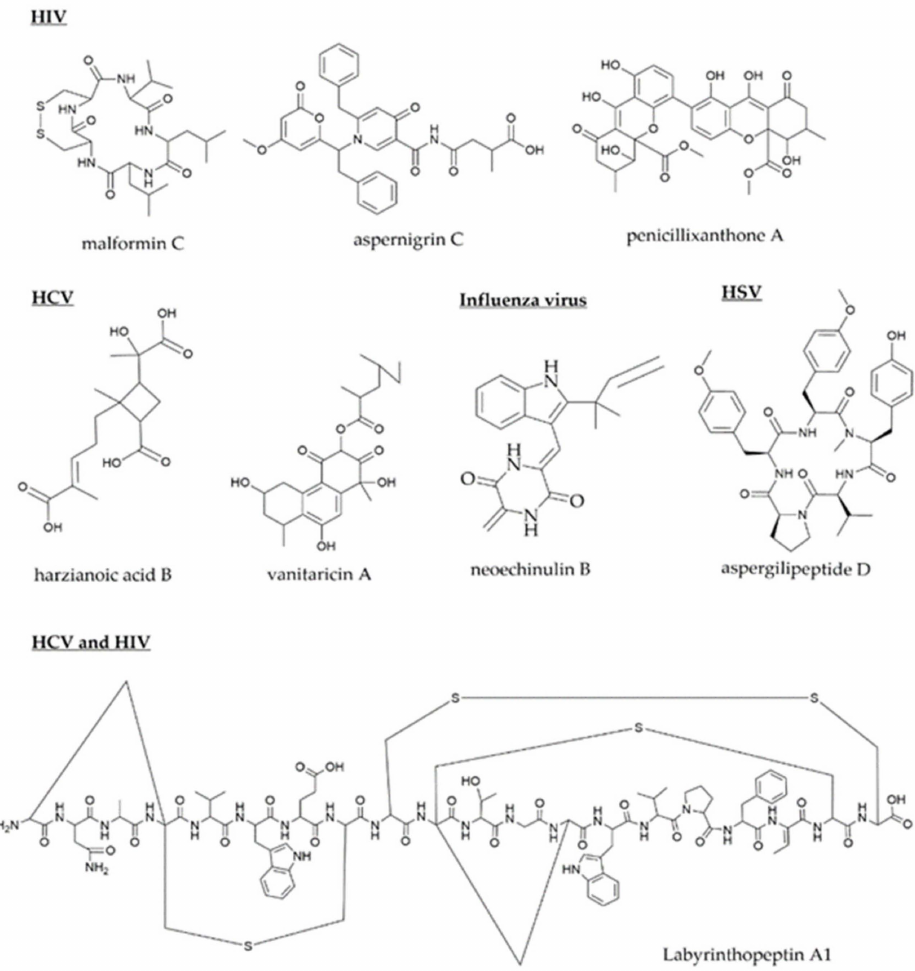
Figure 2. Possible target of viral entry in viruses using microbial natural